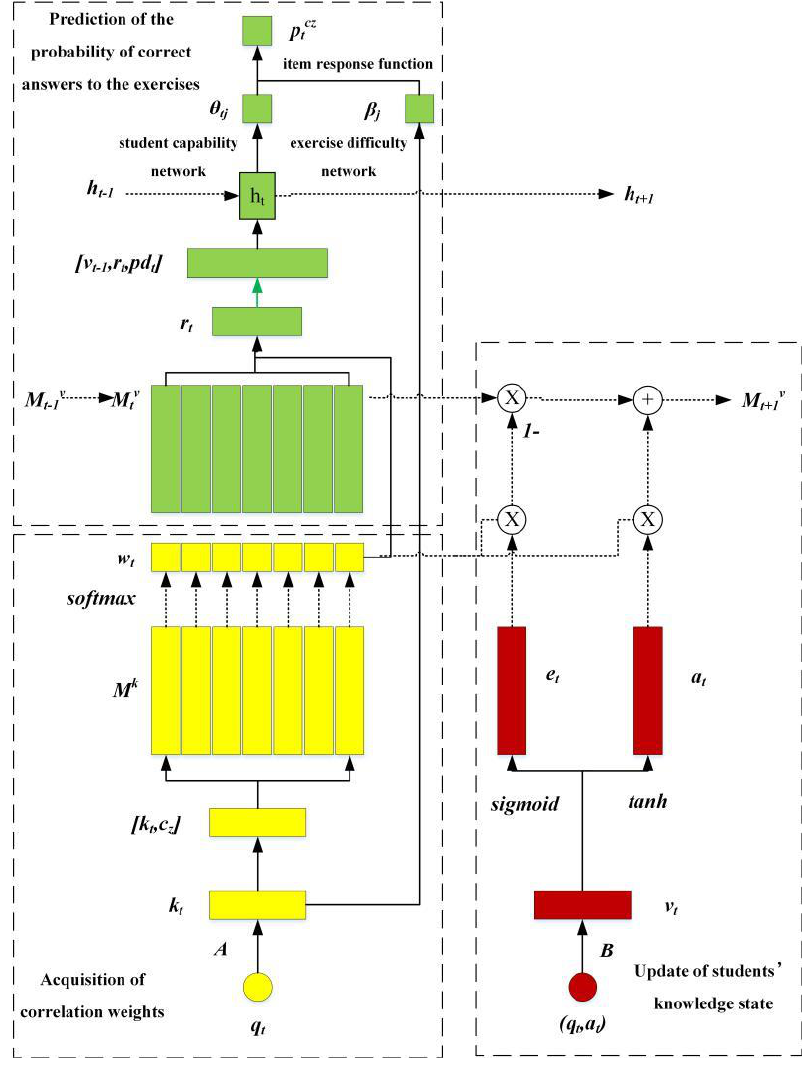
Figure 3. Framework diagram of the DKT-LCIRT model.